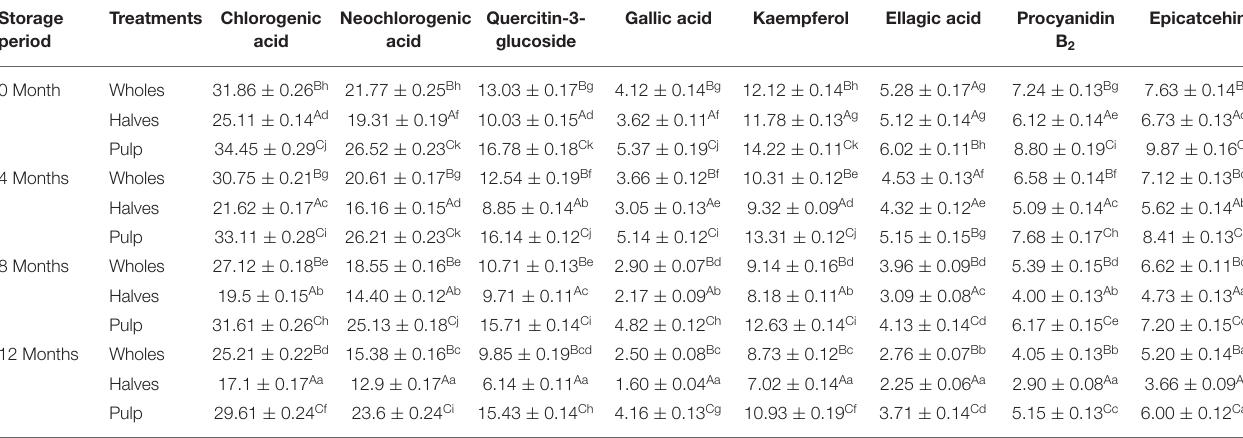
TABLE 3 | Effect of canning and storage on phenolic composition (mg/kg FW) of apricot wholes, halves and pulp. Storage period